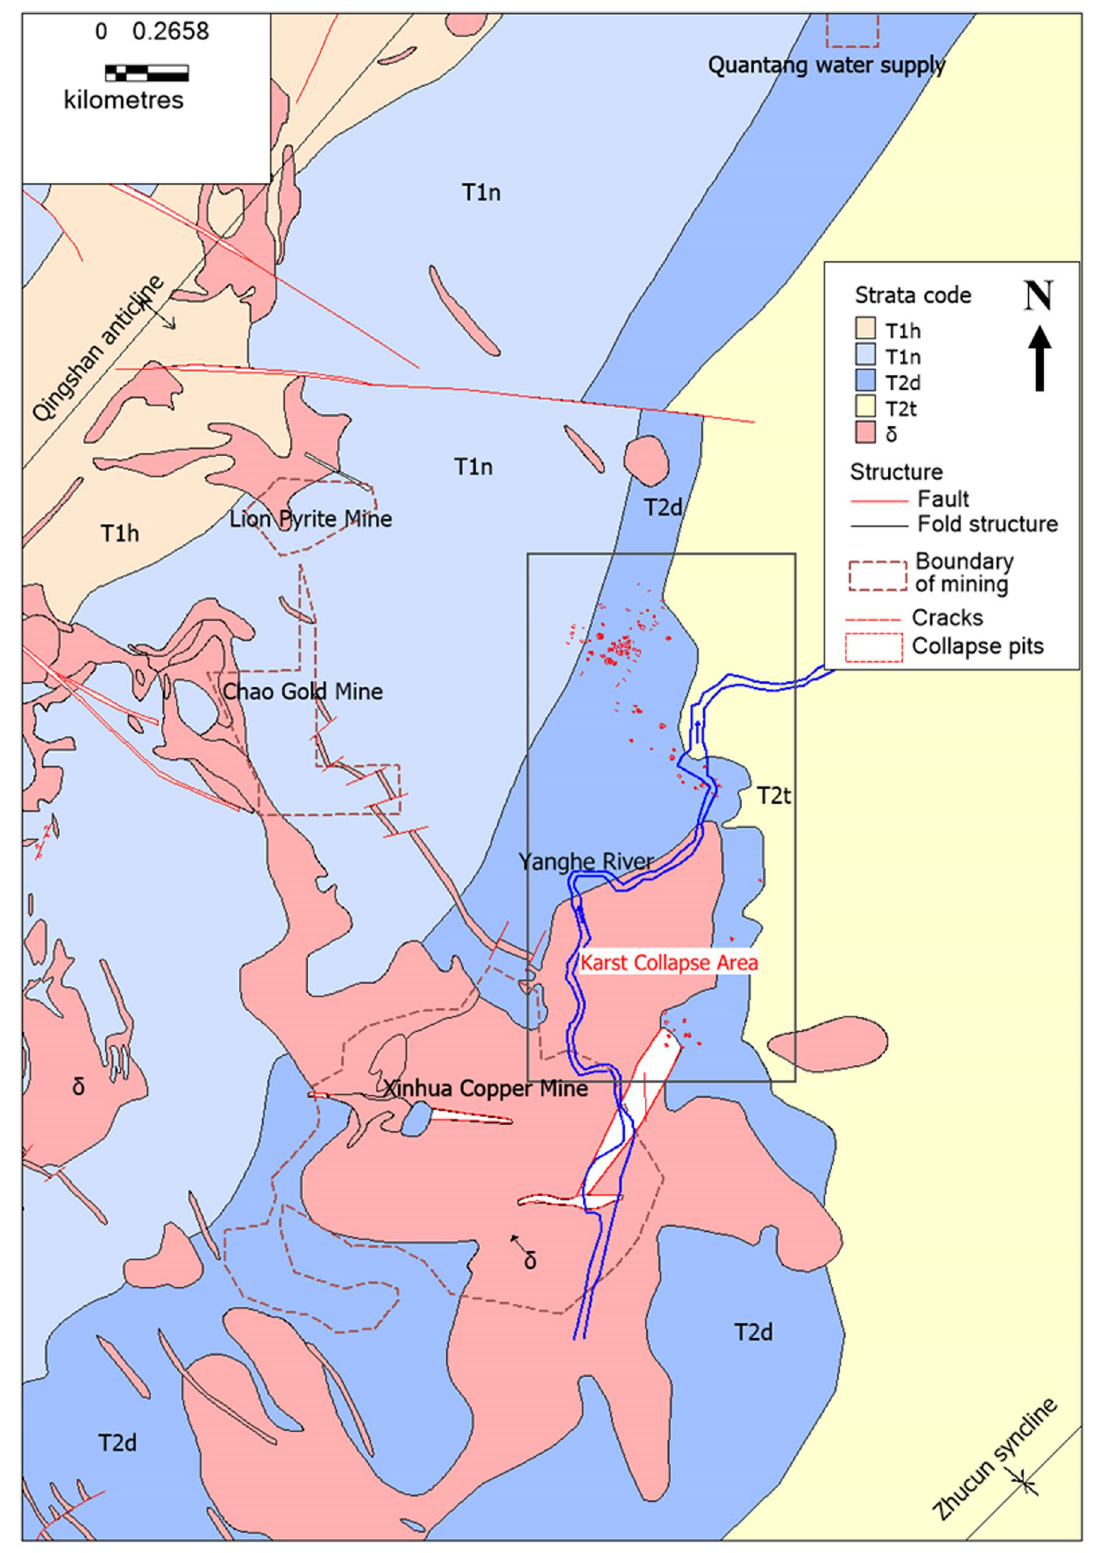
Fig. 1 Regional geology of Chaoshan study area (see Table 1 for legend of